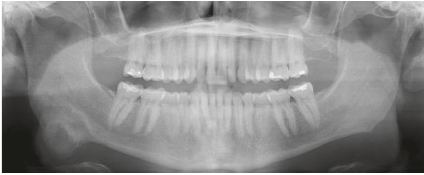
Figure 1: Preoperative orthopantomogram revealing a mixed (radiolucent-radiopaque) lesion, the inferior border of the man- dible in the right angle region.